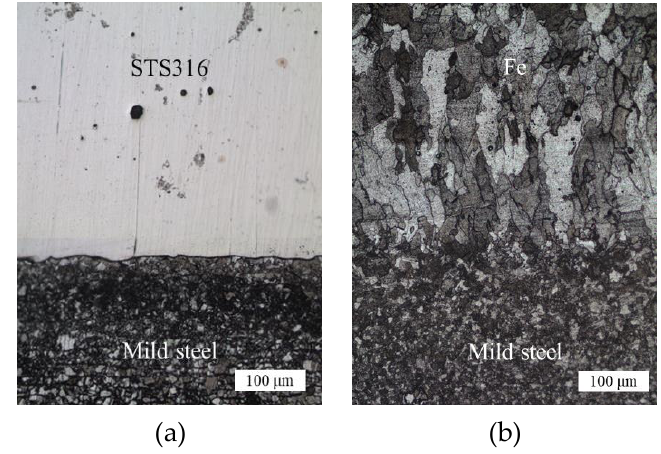
Figure 13. Microstructure of interface between ( a ) sample 1 and ( b ) sample 2.